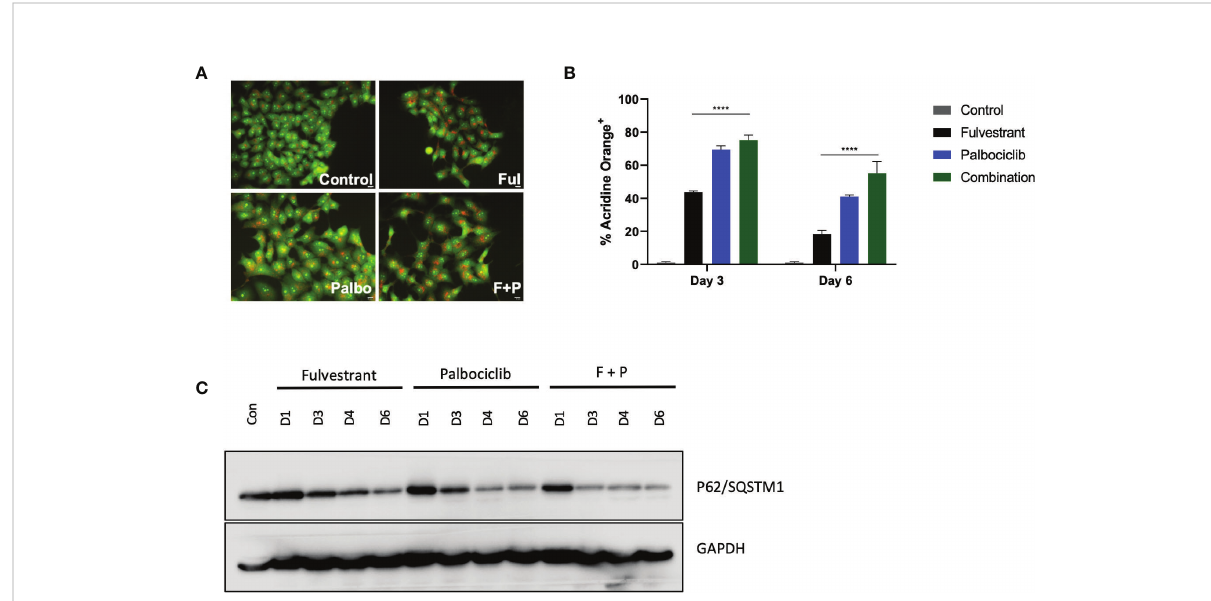
FIGURE 2 Fulvestrant in combination with Palbociclib induces autophagy. Cells were treated with Fulvestrant (100 nM), Palbociclib (1 µM) or the combination for 6 days (A – C) . Lysates were collected at speci fi ed days (A) Cells were stained with acridine orange on day 4 and imaged using a fl uorescent microscope. All images were taken at the same magni fi cation (scale bar= 200 µm, n=3). (B) Cells were stained with acridine orange and fl uorescence was quanti fi ed using fl ow cytometry. (C) Autophagy induction over time was assessed by degradation of p62/SQSTM1 protein levels. All images are representative fi elds or blots from at least three independent experiments. ****P ≤ 0.001 indicate statistical signi fi cance of each condition compared to Fulvestrant as determined using two-way ANOVA with Sidak's post hoc